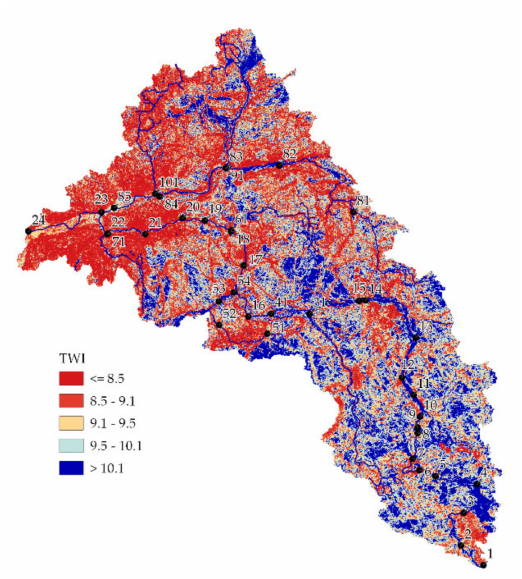
Figure 3. Distribution of Topographic Wetness Index TWI for the Warta River basin. Geochemical conditions in the Warta River catchment, which describe the phosphorus, calcium and iron concentrations found in a 20 cm topsoil, are shown in Figure 4.